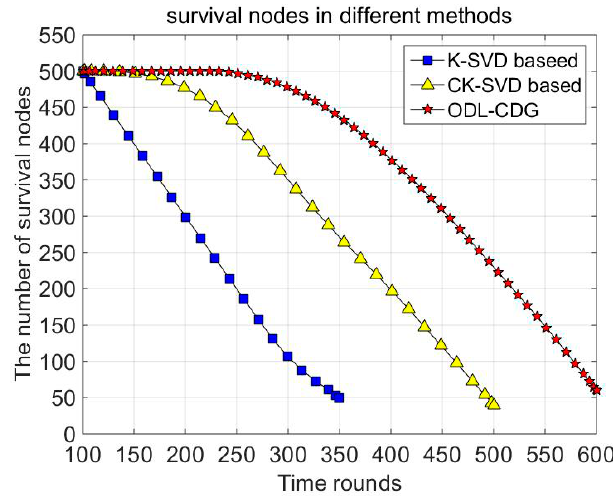
Figure 7. The number of survival nodes in different methods.